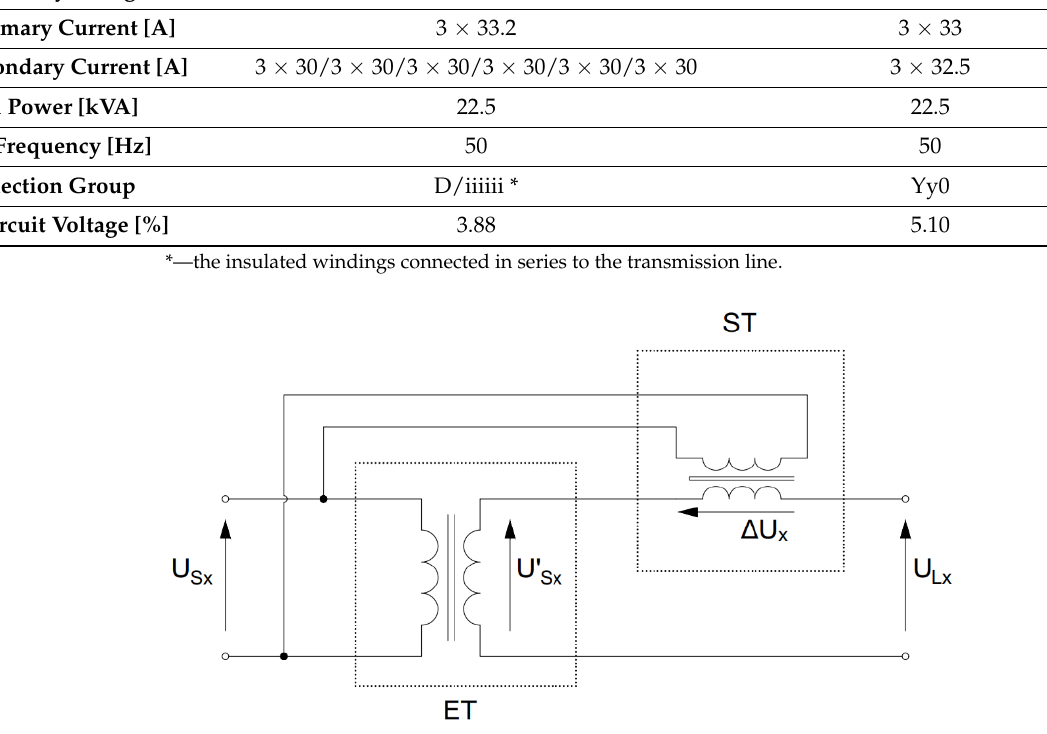
Figure 5. The ACPST single-phase equivalent scheme. ET — extra transformer responsible for longitudinal voltage regulation, ST — series transformer implementing quadrature voltage into the line, USx — input voltage of any phase, U’Sx—regulated longitudinal voltage of any phase, ΔUx— quadrature voltage injected into the line, ULx — PST output voltage of any phase. The regulation and possible angles and output voltage values for the laboratory ACPST are shown in Figure 6.